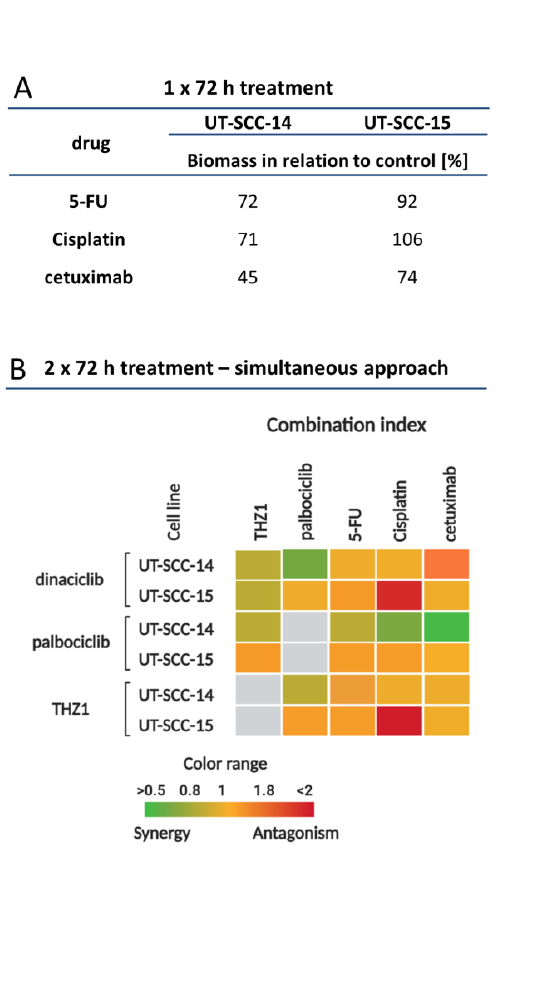
Figure 1. Simultaneous and sequential treatment schedules. ( A ) Biomass quantification after monotherapy with 5-FU, Cisplatin, and cetuximab (1 × 72 h). Doses used here were determined before using classical dose response curve analysis. Read out was done by crystal violet staining and biomass in relation to untreated controls quantified. In ( B ) the Bliss Independence model was used to calculate potential synergistic effects. The green color indicates a synergistic and red color an antagonistic effect of the simultaneous combinations. ( C – E ) Sequential treatment: ( C ) dinaciclib [0.005 µM], ( D ) palbociclib [1 µM], and ( E ) THZ1 [UT-SCC14: 0.02 µM; UT-SCC-15: 0.005 µM] in comparison to 2 × 72 h CDKi monotherapy (first bar of each graph). Drug doses were as follows: 5-FU [0.32 µg/mL]; Cisplatin [UT-SCC14: 0.5 µg/mL; UT-SCC-15: 0.05 µg/mL]; cetuximab [0.5 µg/mL]. Mann Whitney U-test ( n = 3–4 independent experiments) # p < 0.05, ## p < 0.01 vs. 1st CDKi; Kruskal Wallis test ( n = 3–4 independent experiments) * p < 0.05, ** p < 0.01 vs. monotherapy. The 1 × 72 h monotherapy with 5-FU, Cisplatin or Cetuximab confirms that the potential enhancing effect of sequential combination therapy is not due to the single administration of these substances but the effect of the 2 × 72 h CDKi monotherapy (in the left bar) is actually enhanced.